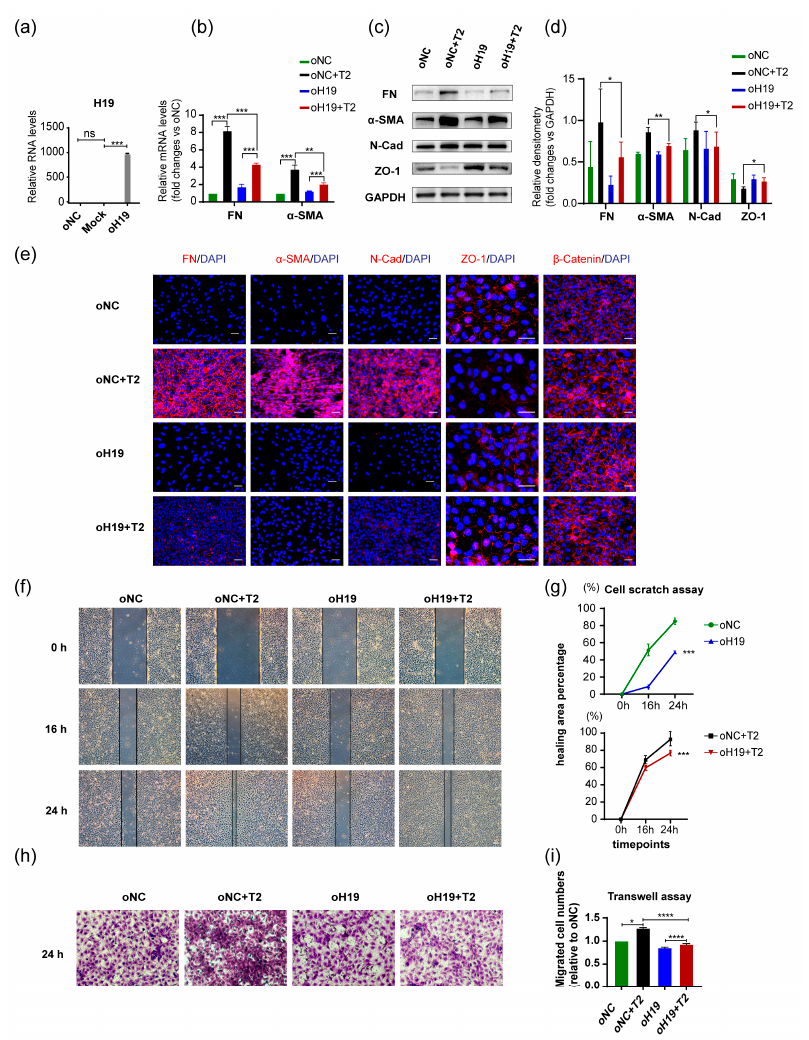
Figure 5. Upregulation of H19 in SRA01/04 cells partially restored lens epithelial cell properties. ( a ) After SRA01/04 cells were infected with the H19 -overexpressed lentiviruses for 48 h, H19 expression was validated by quantitative real-time PCR. ( b ) RNA analyses of FN and α SMA in SRA01/04 cells after infection for 24 h and further exposure to TGF- β 2 for 24 h. ( c – d ) Protein levels of mesenchymal markers FN, α -SMA, N-Cad, and epithelial cell junction marker ZO-1. Representative western blots are shown here. Protein quantification data are expressed as a ratio to GAPDH. ( e ) Staining of FN, α -SMA, N-Cad, ZO-1, and β -catenin in SRA01/04 cells. ( f – i ) After infection with o H19 , the migration capacity of SRA01/04 cells induced by TGF- β 2 was detected by wound-healing assay ( f , g ) horizontally and Transwell assay ( h , i ) vertically. Image J was used for further quantification. Scale bars, 50 µ m. * p < 0.05, ** p < 0.01, *** p < 0.001, **** p < 0.0001, ns: not significant. oNC, normal control for overexpression lentiviruses; o H19 , H19 overexpression